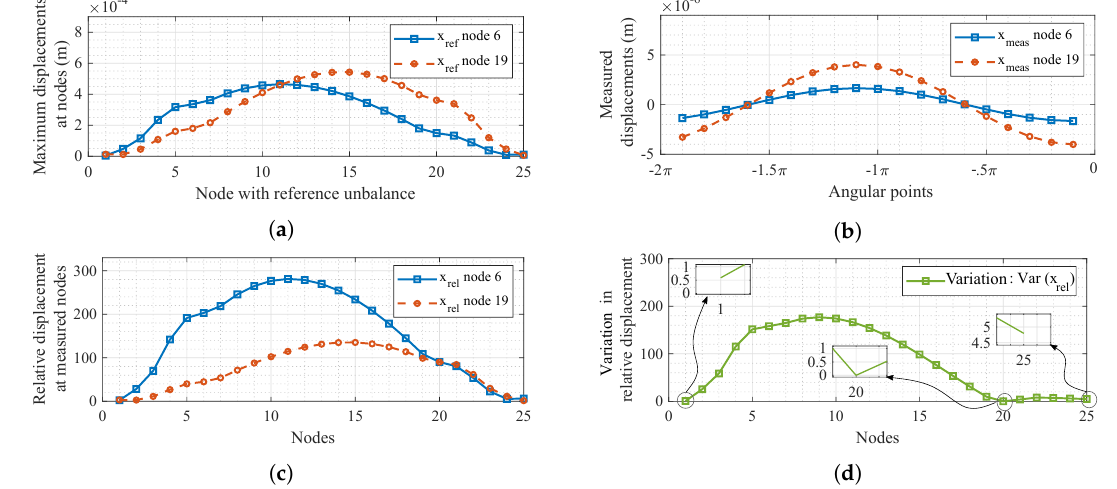
Figure 7. Identification of the unbalance location using the displacement comparison method for the tube roll. The induced unbalance (magnitude of 0.056 kg · m and 0 degree phase) is located at node 20. Subplots ( a ) The maximum amplitude (x ref ) of each node for individual reference cases where the unbalance location varies from node 1 to node 25 consecutively in the FE model. ( b ) Measured displacements (x meas ) at bearing locations with the maximum amplitudes identified. ( c ) Relative displacement (x rel ): reference cases (x ref ) divided by max. measured displacements. ( d ) Variation at each node: the minimum value gives the unbalance location.